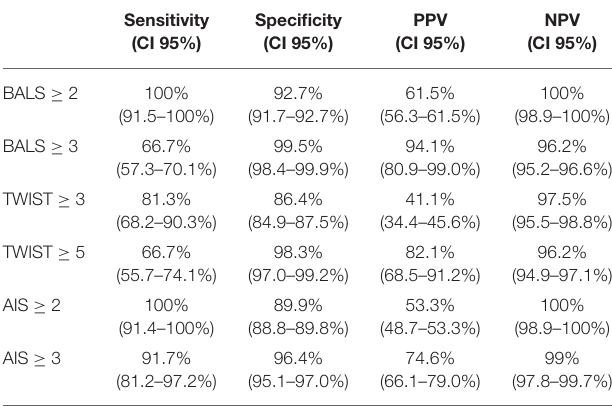
TABLE 3 | Predictive capabilities of the current and the new score in predicting TABLE 2 | Clinical data for children TT compared to non-TT. testicular torsion in the entire cohort of children with acute TT Non-TT